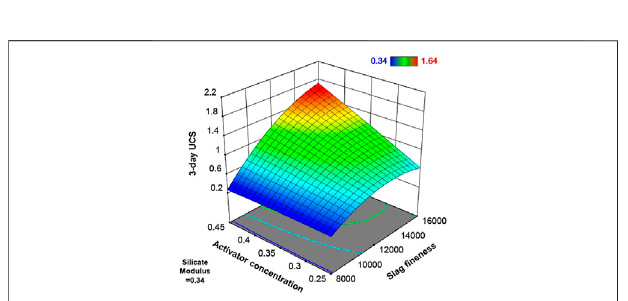
FIGURE8| Response-surfaceofthein fl uenceofactivatorconcentration and its interaction with slag fi neness for a silicate modulus of 0.34.